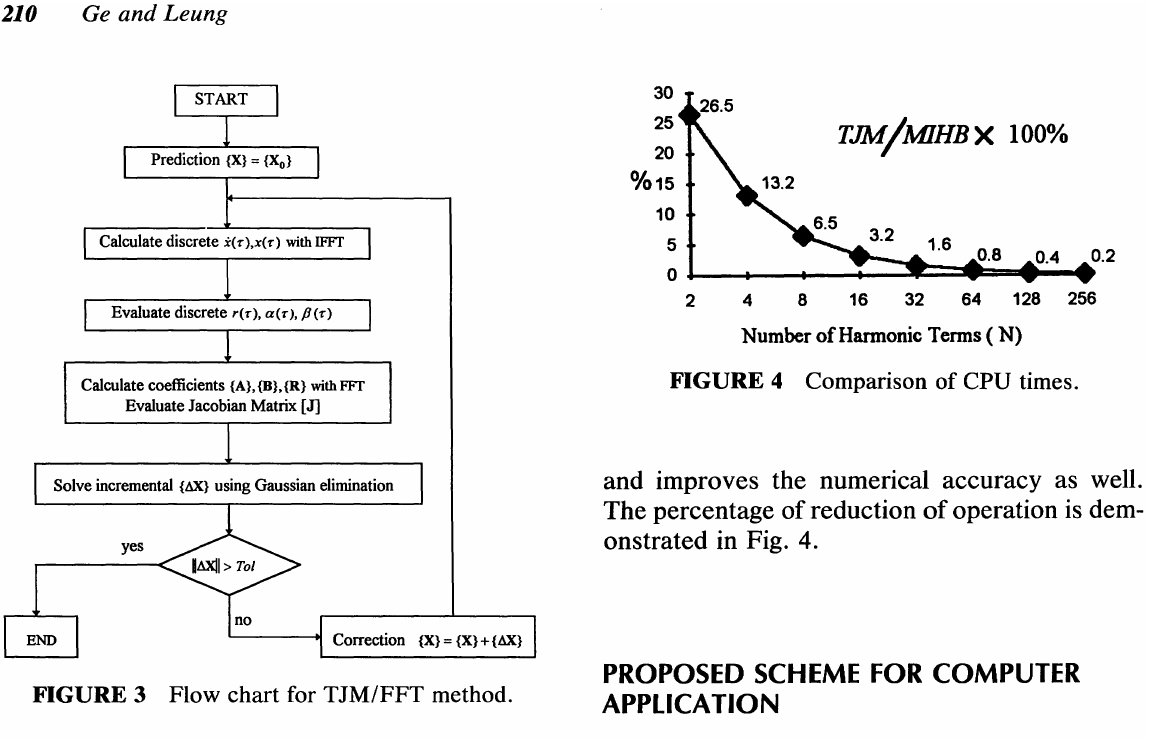
FIGURE 3 Flow chart for TJM/FFT method.